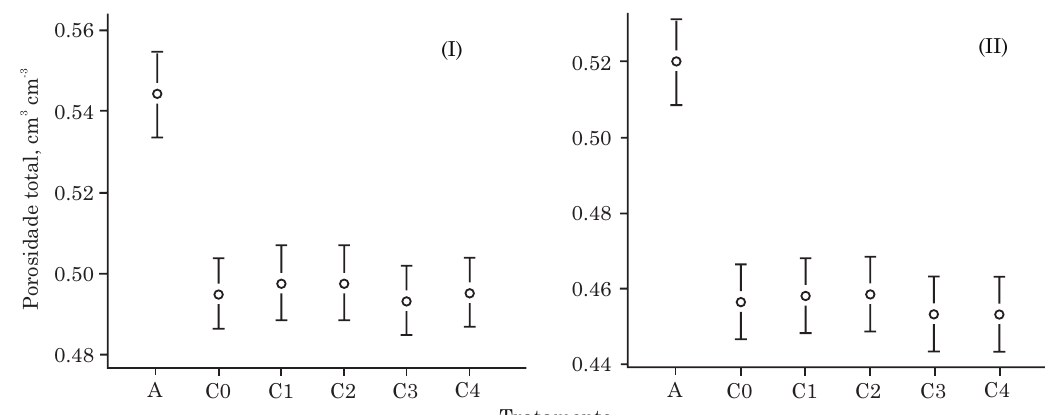
Figura 6. Valores médios de porosidade total de dois Latossolos Vermelhos distróficos, um argiloso (I) e um franco-argilo-arenoso (II), nos tratamentos A, C0, C1, C2, C3 e C4. As barras representam o intervalo de confiança da média (85 %).